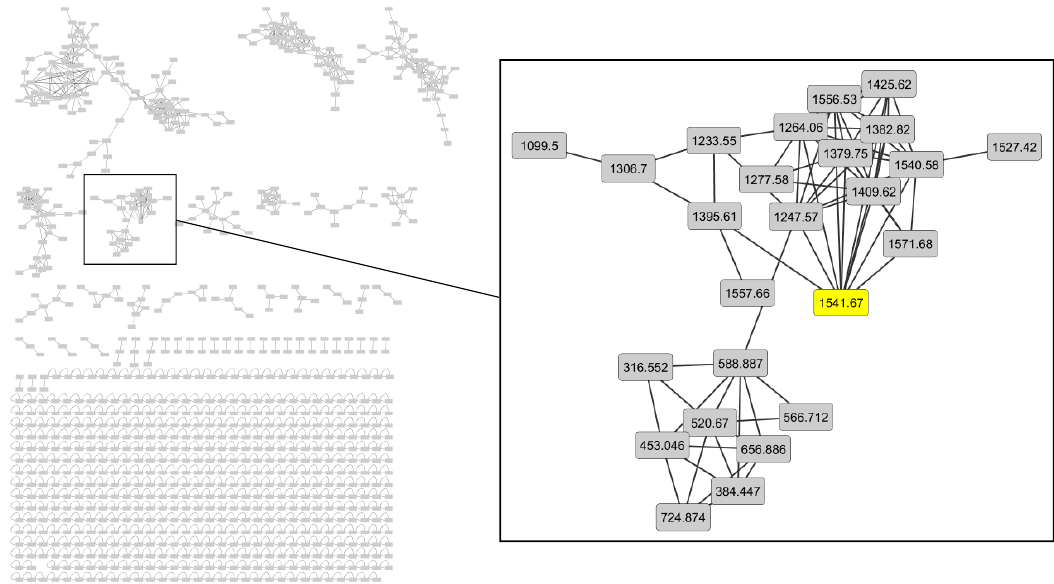
Figure 1. Molecular network in negative ion mode with the cluster containing herniariasaponin H shown in detail.